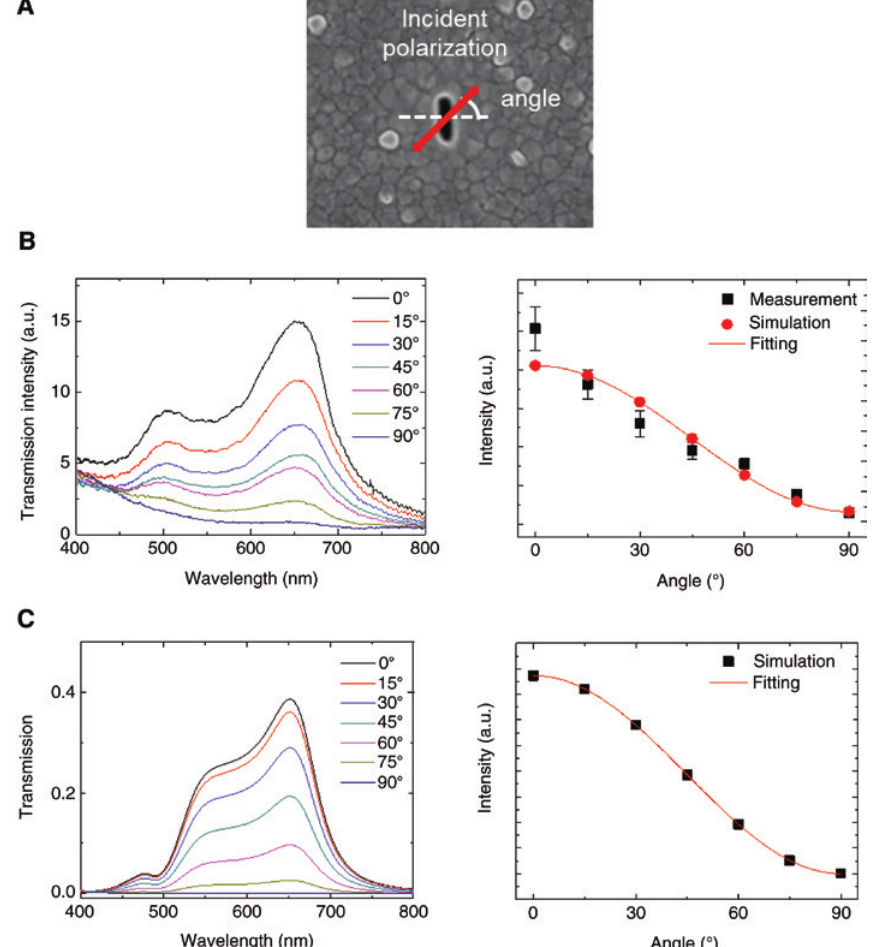
Figure 4: Polarization property of a metallic nanoslot. (A) SEM image of single slot with 145 nm length and schematics of the incident polarization angle, (B) spectra measured while changing the polarization angle of the incident light (left) and the graph of the maximum intensity as a function of the polarization angle (right), and (C) spectra simulated by the 3D-FDTD simulation (left) and the redrawn graph